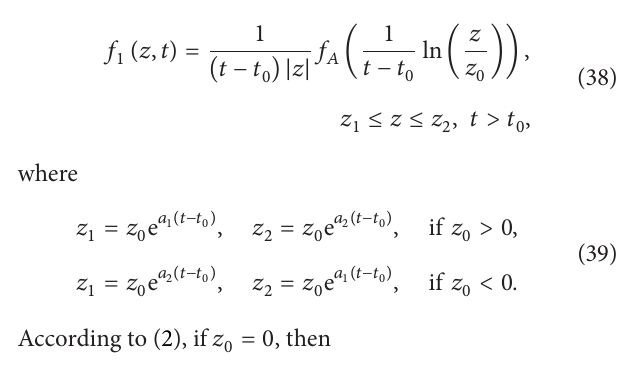
Figure 1: Plot of 𝑓 1 (𝑧,𝑡) given by (35) in Example 10 at different values of 𝑡 = {0, 0.25, 0.5, 0.75, . .. ,2} (corresponding to the solid lines) in the case that 𝑍 0 ∼ 𝑁(𝜇 = 0; 𝜎 2 = 1) , 𝑡 0 = 0 , and 𝑎 = −1